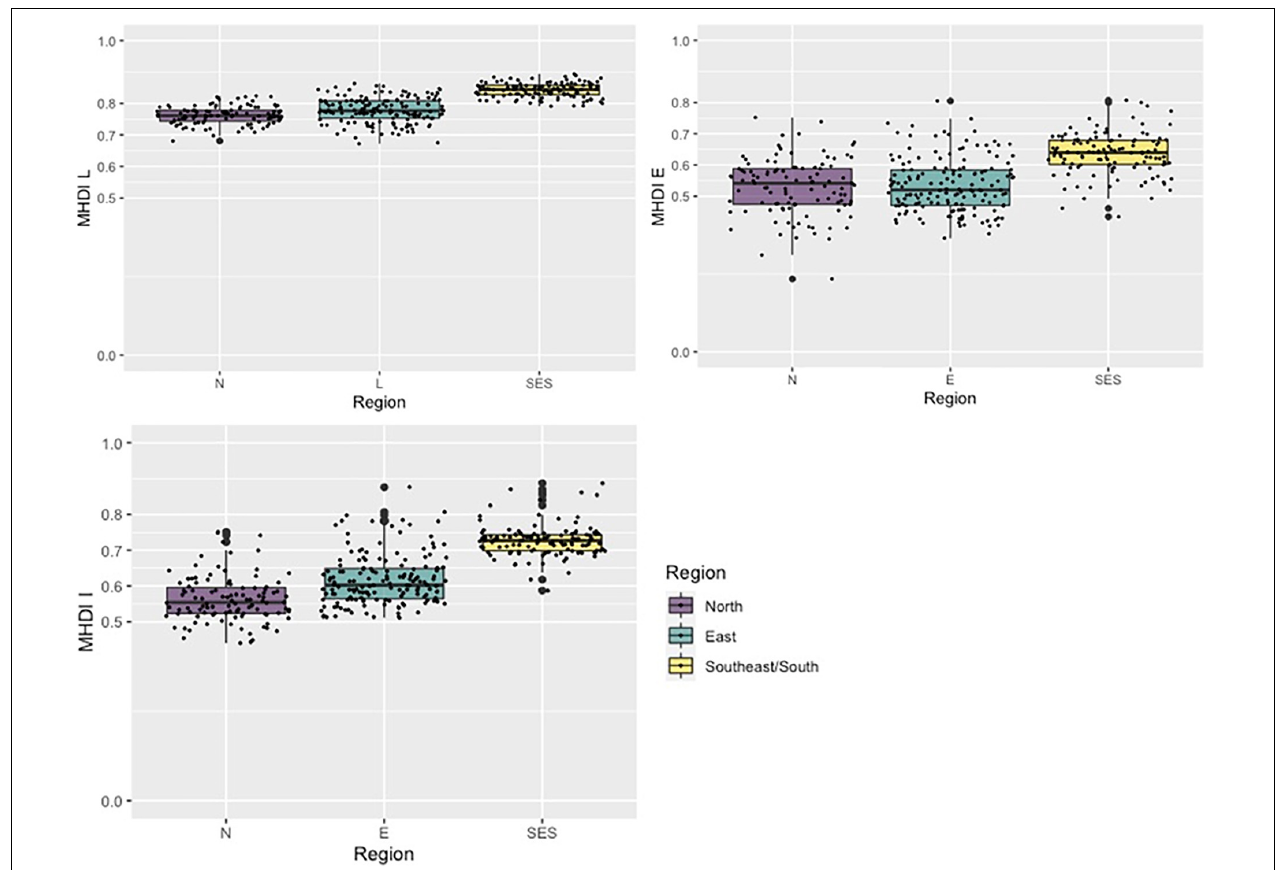
FIGURE 5 | Distribution of the coastal municipalities for their MDHI dimensions. Elaborated by the authors with data from PNUD et al.